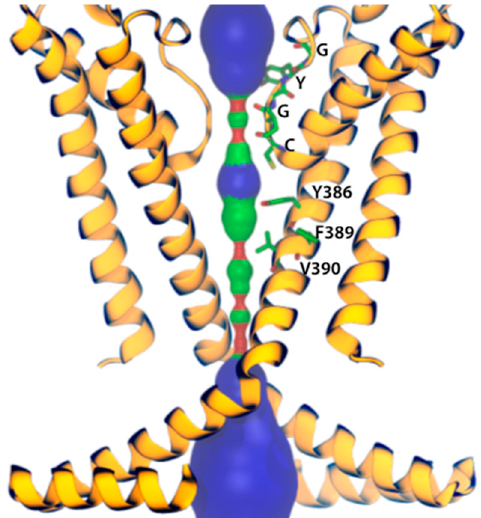
Figure 3. The HCN1 subunit pore. Only two subunits are shown for better visualization. The pore is shown in red where the pore radius is <0.6 Å, green where it is between 0.6 Å and 1.15 Å, and blue where it is >1.15 Å. Residues mediating ivabradine binding and those forming the selectivity filter are represented as sticks.